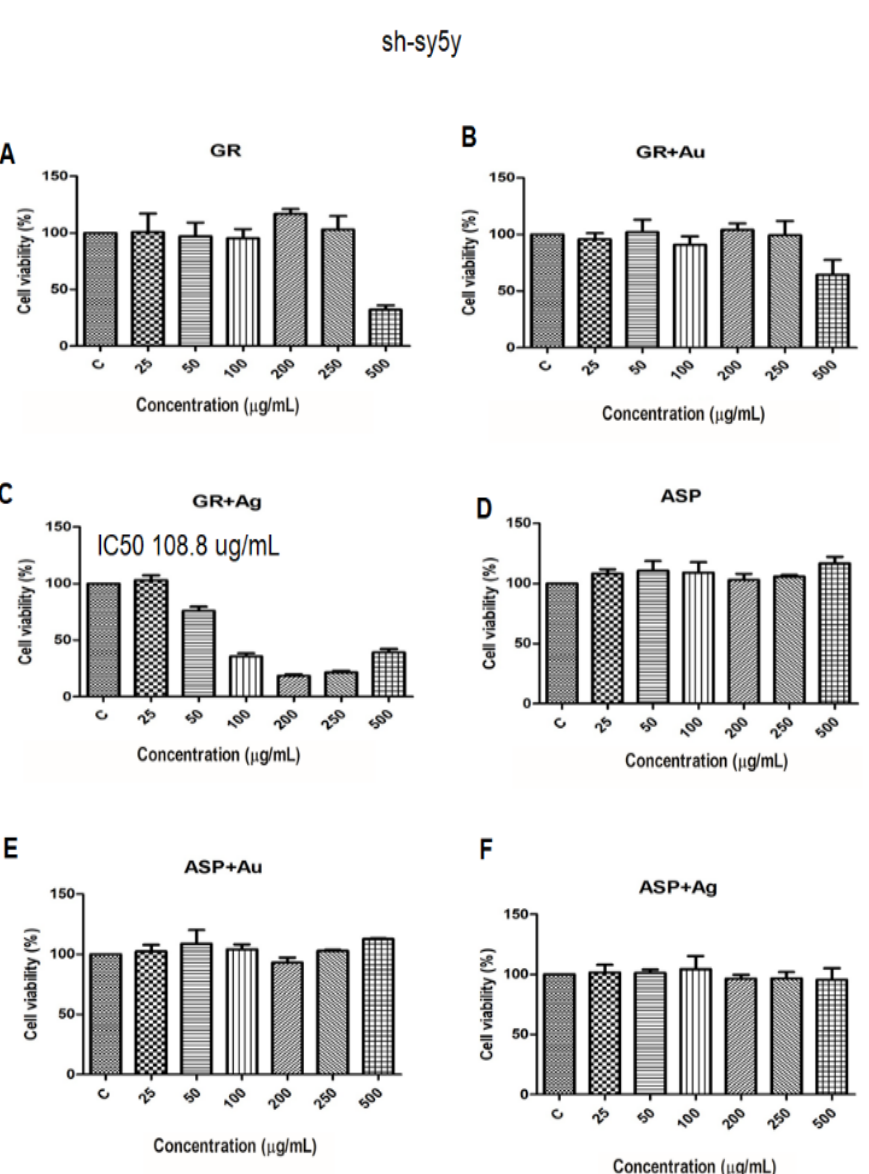
Figure 9. The results of the MTT assay in sh-sy5y treated with GR total extract ( A ), GR-AuNPs ( B ), GR-AgNPs ( C ), ASP ( D ), ASP-AuNPs ( E ), ASP-AgNPs ( F ) after 24 h (results are reported as the viability in comparison with the control sample). Among the tested samples, the IC 50 concentration (Subgraph C ) was most cytotoxic at concentrations 50–100 μ g/mL.